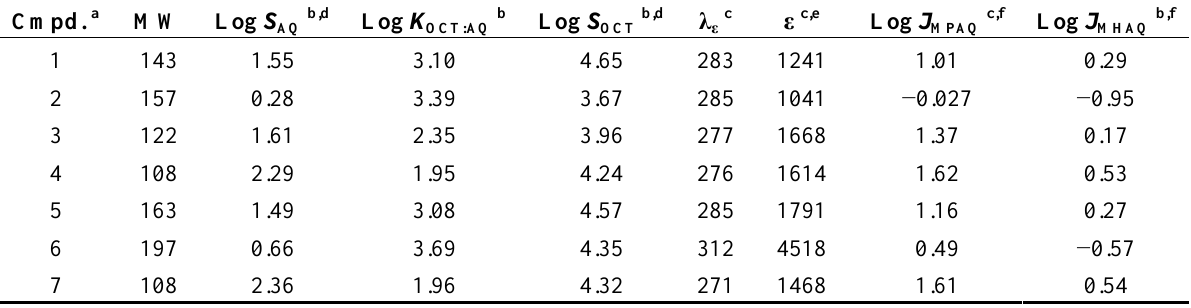
Table 1. The relevant measured or literature physicochemical properties for the n = 7 phenolic compounds used in this